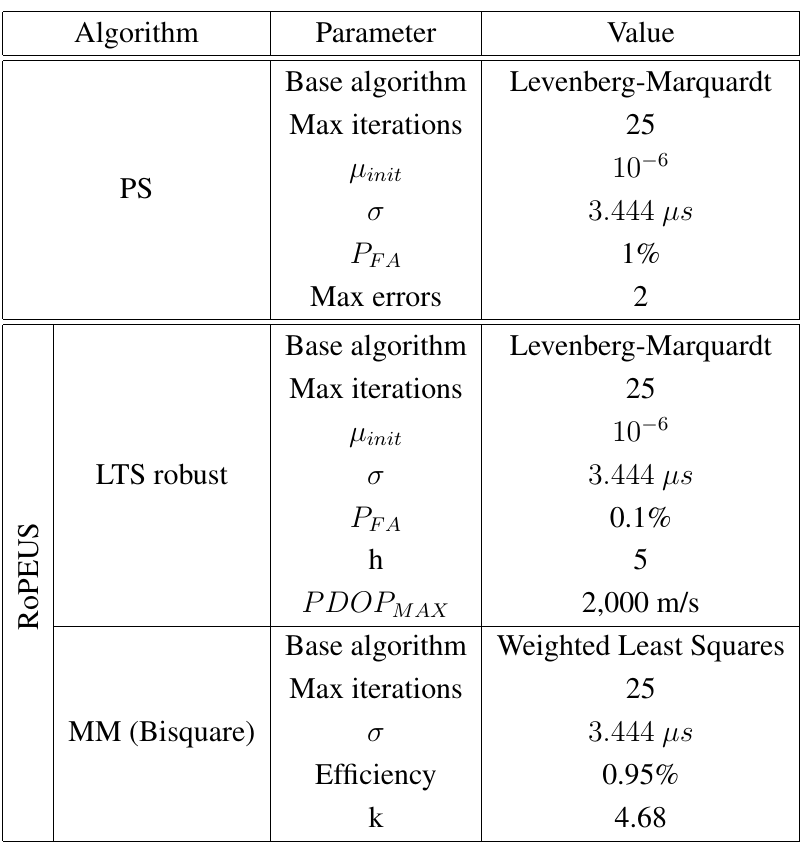
Table 3. Main configuration parameters employed in the